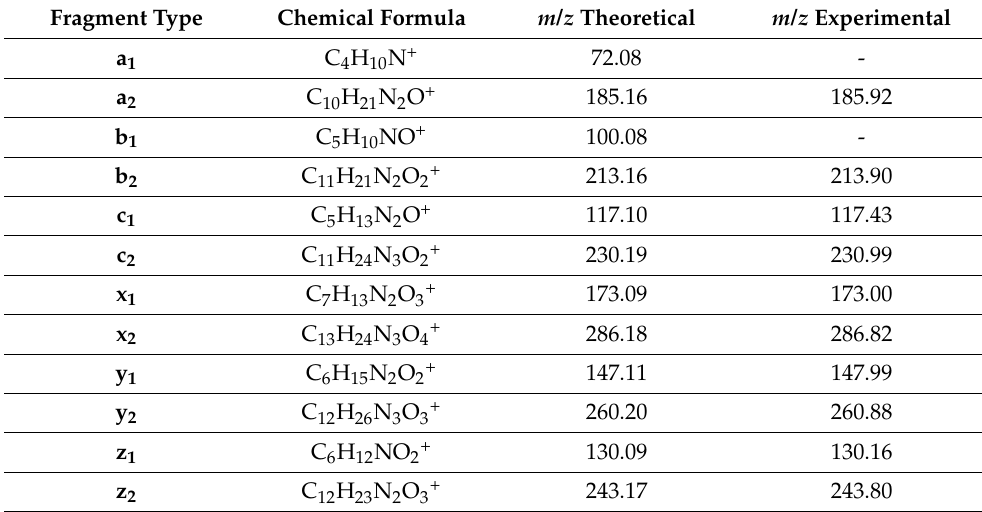
Figure 10. Theoretical fragmentation of the Val-Ile-Lys peptide. Table 4. Types of fragments identified in the MS spectra corresponding to the VIK peptide. Fragment Type Chemical Formula